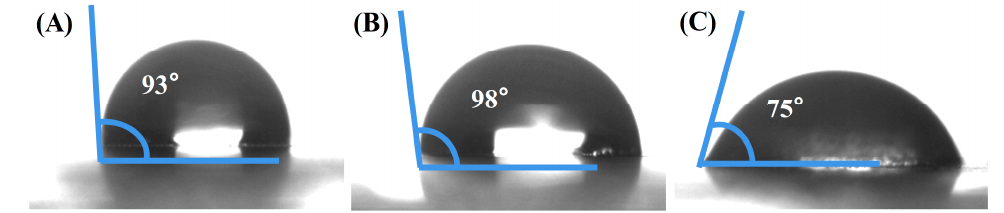
Figure 6. The contact angles of water on the ( A ) hexagonal MLAs, ( B ) circular MLAs, and ( C ) square MLAs.